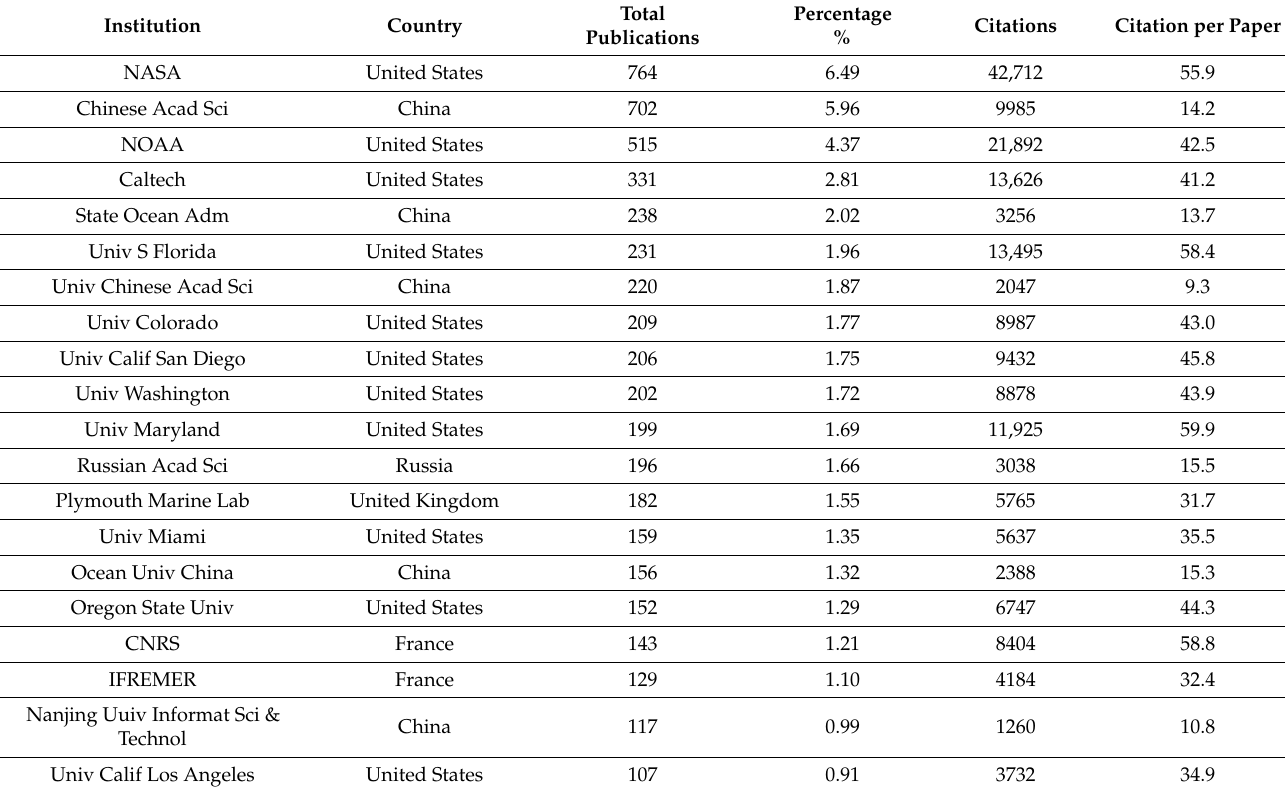
Table 2. Top 20 institutions based on total publications.